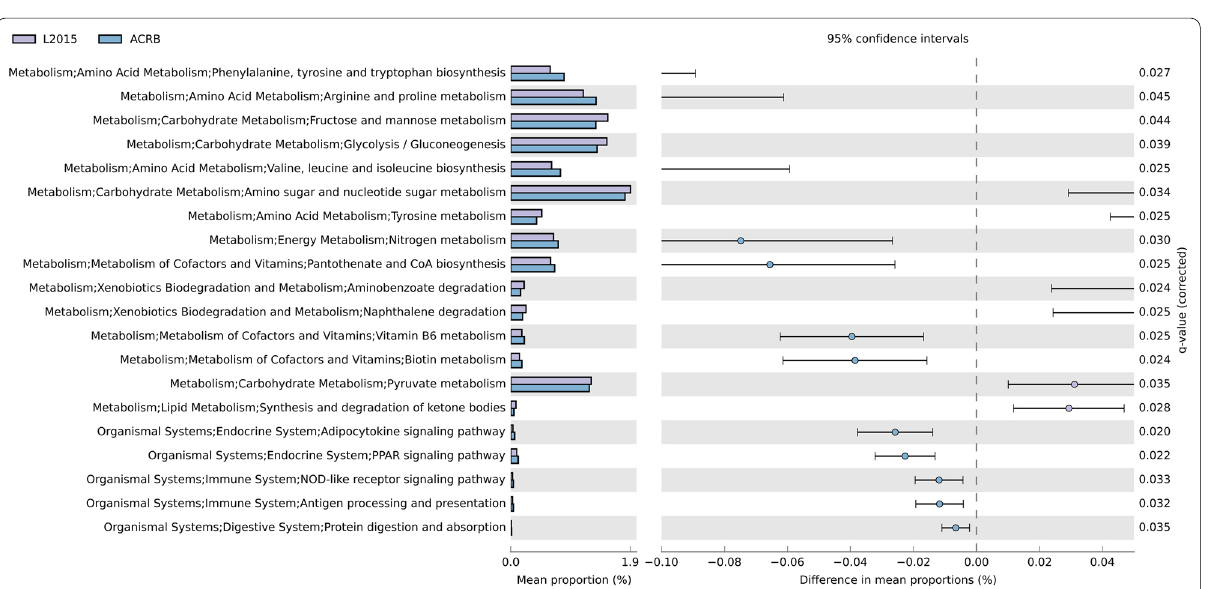
Fig. 12 Predicted functions of ileal mucosa microbiota in modern random bred chickens (L2015) compared to Athens‑Canadian Random bred chickens (ACRB) on d 56. Differentially regulated (top 20) metabolic pathways are shown. (n